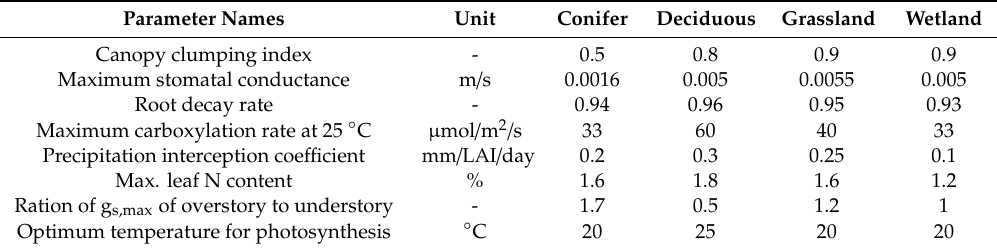
Table 1. Biophysical parameters of major landscape types in the Upper Heihe watershed.